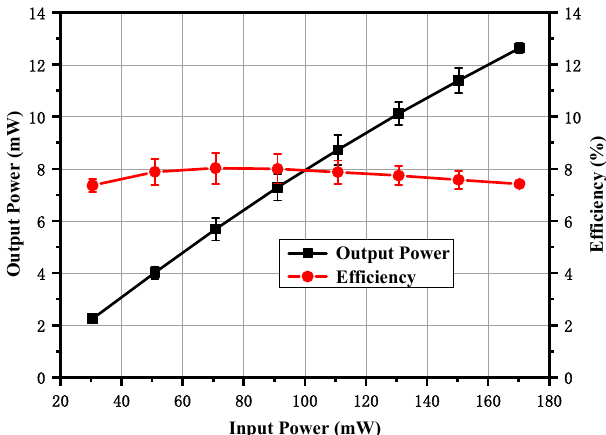
Figure 13. Measured output power and efficiency versus input power at 166 GHz under 50 Ω self-bias resistor.